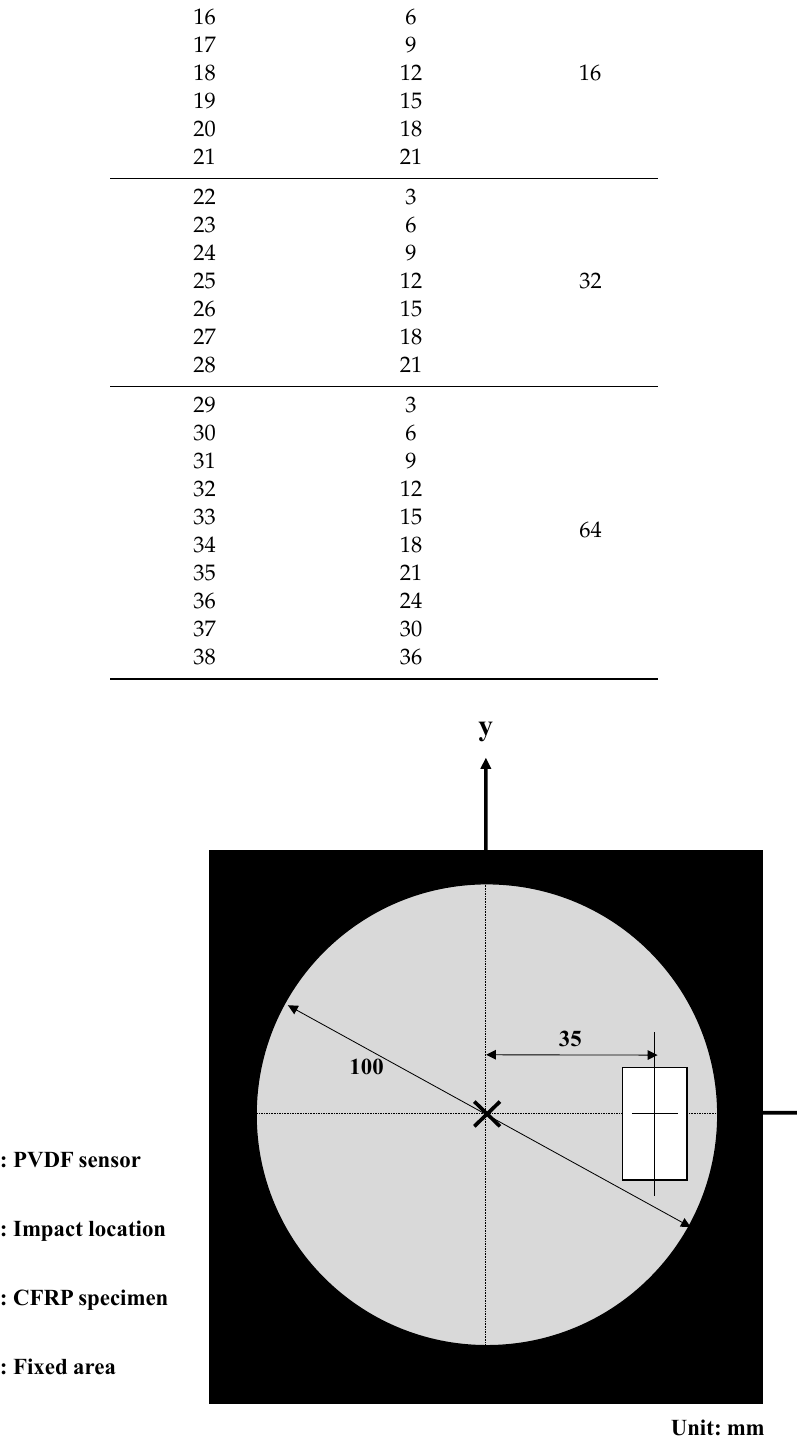
Figure 3. A schematic of the geometry of the test specimens and the location of the poly(vinylidene fluoride) (PVDF) sensor.